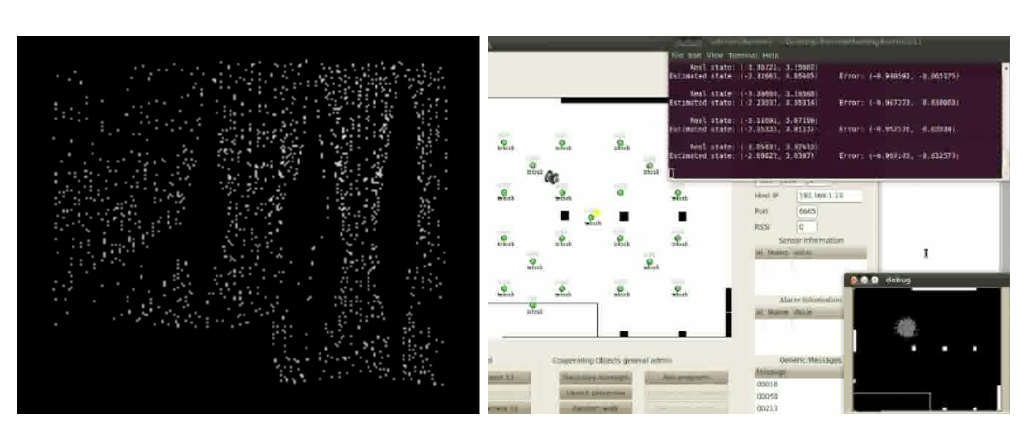
Figure 8. (Left) RSSI raw measurements map for node n20 ; (Right) Snapshot showing the particles estimated location and real robot location during a remote experiment.